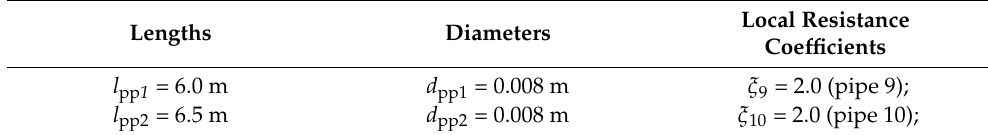
Table 4. Lengths, diameters and local resistances of liquid